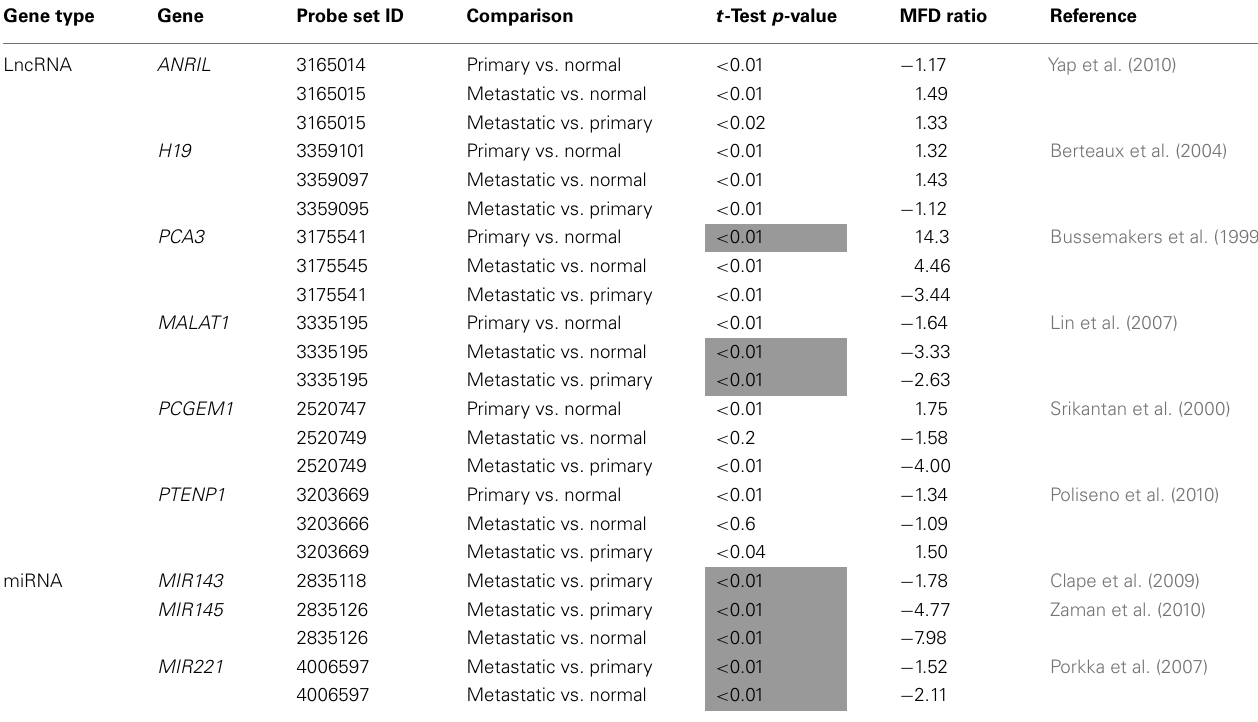
Table 3 | Long non-coding RNAs previously reported as differentially expressed in prostate